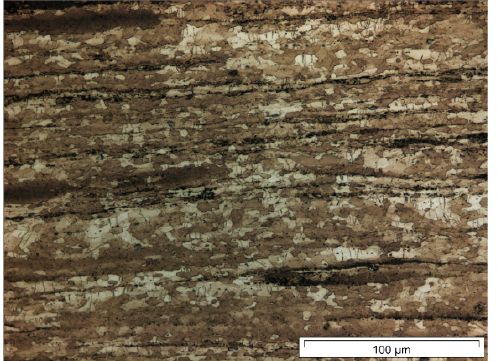
Figure 9. Microstructure obtained near the fractured zone after tensile test at room temperature and strain rate of 10 − 3 s − 1 .